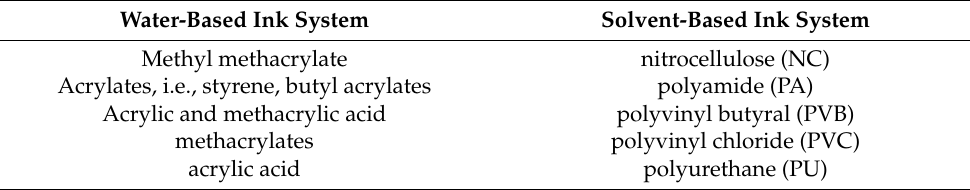
Table 2. Binder chemicals for water-based and solvent-based ink